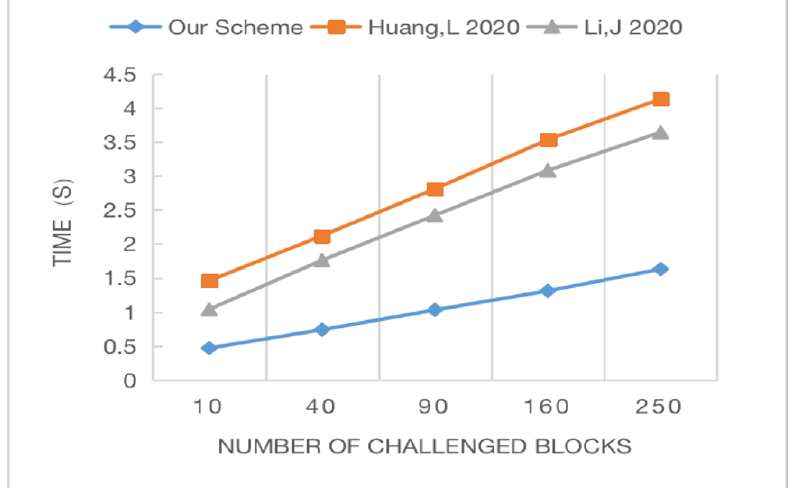
Figure 4. Computational cost for ProGen [4,17].